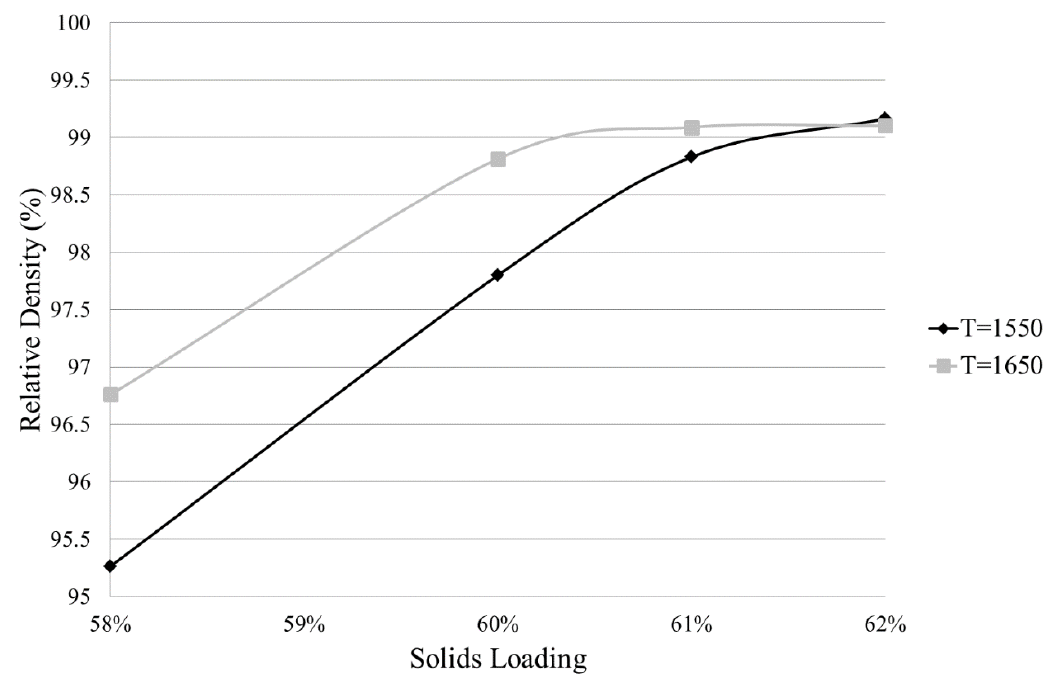
Figure 5. Relative density obtained at solid loadings ranging from 58%–62% at sintering temperatures of 1550 °C and 1650